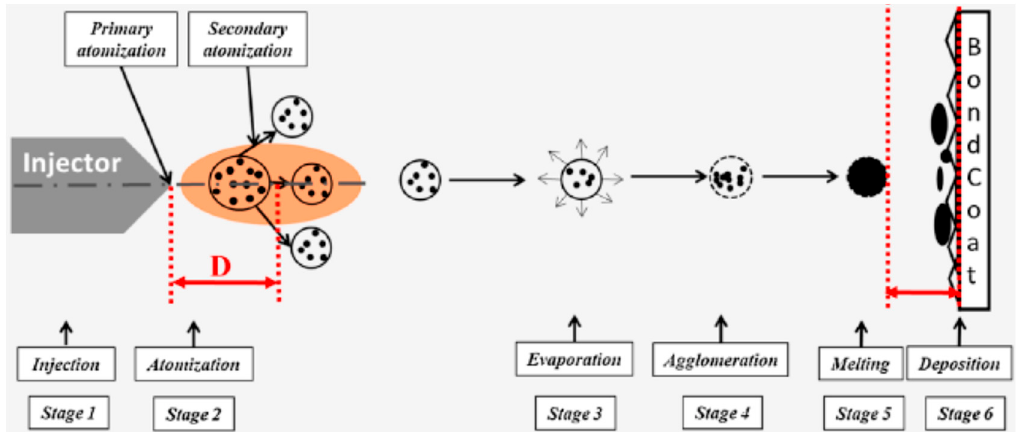
Figure 5. Schematic of various stages leading to coating formation by suspension plasma spraying